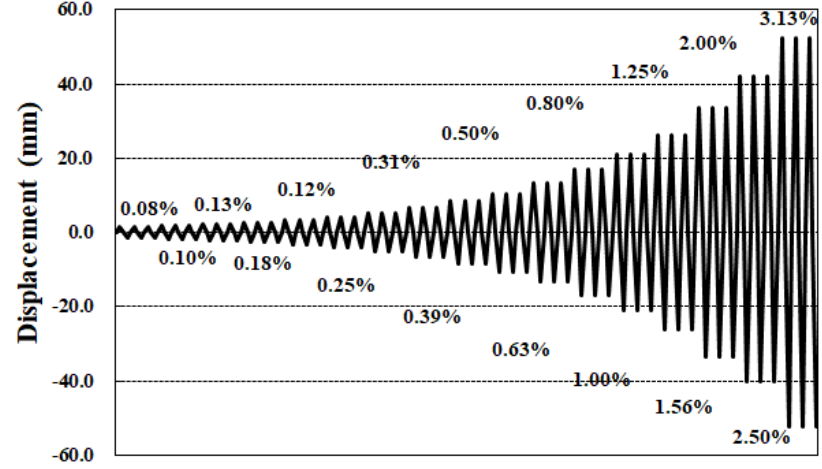
Figure 10. Cyclic loading protocol.